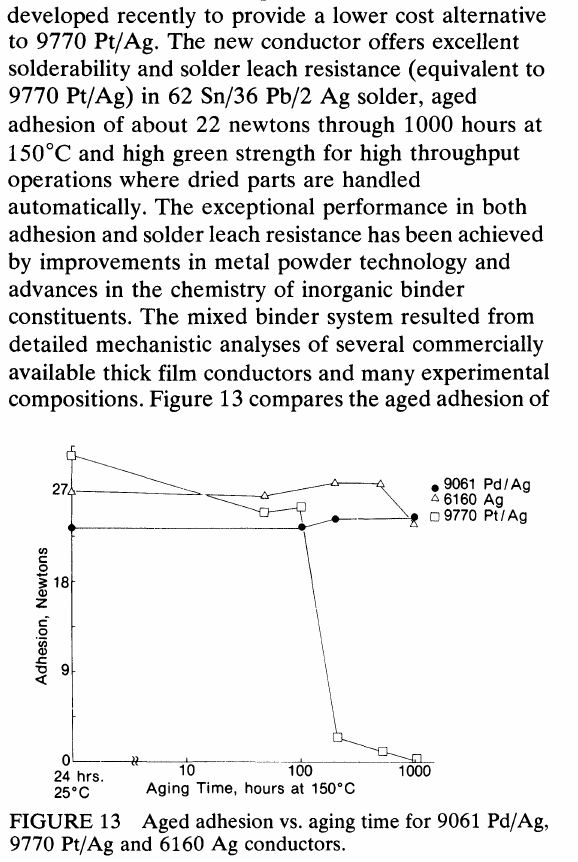
FIGURE 13 Aged adhesion vs. aging time for 9061 Pd/Ag, 9770 Pt/Ag and 6160 Ag conductors.